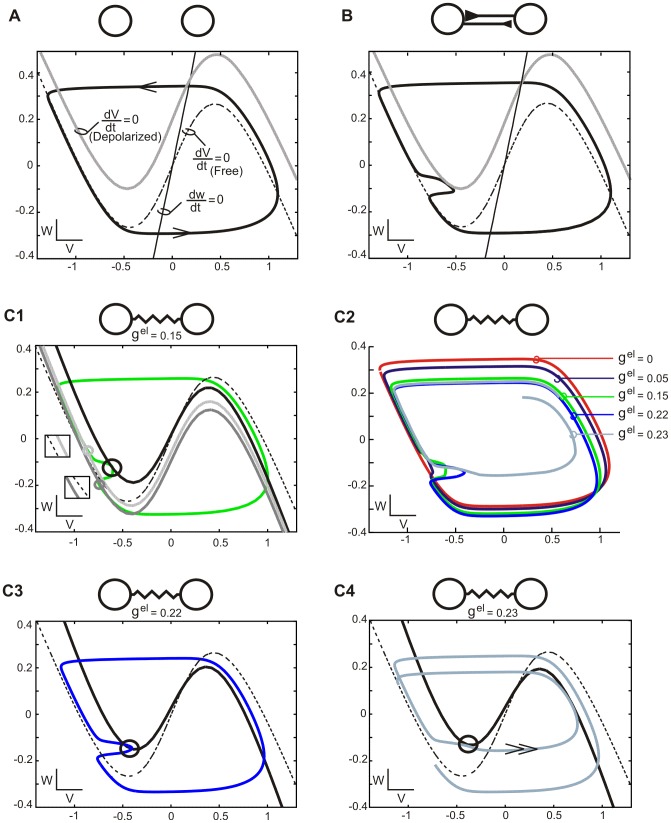
Phase plane evolution of oscillators involved in the 2-phase behavior in fully connected network.A. Trajectory of an uncoupled oscillatory cell (black curve) on the phase plane. Evolution along left and right branches of V-nullcline (dashed cubic curve) corresponds to the active and silent phases, respectively. Transitions between the phases occur when the cell jumps up from the left knee or jumps down from the right knee of the V-nullcline (see arrows). The speed of evolution is high during jumps as compared to evolution along V-nullcline when it is inversely proportional to the distance between the actual position of the cell and the W-nullcline (black straight line). Also shown is the V-nullcline for depolarized system (grey cubic curve). B. AP trajectory of 2 cells coupled reciprocally by excitatory synapses. The trajectory (black curve) is identical as in A, except for a right-sided deflection, corresponding to the evolution along the new V-nullcline (grey cubic curve) of the depolarized cell, which is shifted up with respect to the free nullcline (dashed cubic curve). C. AP trajectory of electrically coupled cells. The trajectory of two identical groups of cells expressing anti-phase oscillation (green curve, C1) is compressed comparing to the free cell trajectory (black curve, A) due to continues interaction of two groups all over the cycle. Shown are positions of cells before, during and after the other group's active phase (light grey, black and dark grey circle, respectively) and corresponding nullclines (light gray, black and dark grey cubic curves). Notice shift of the nullclines with respect to the free nullcline (dashed cubic curve) (inserts, C1). Increasing gel produces gradual compression of the AP trajectory (color curves, C2) and changes a position of cells (black circles) with respect to the knee of V-nullcline (black cubic curve) during a maximal deflection (C3-4, see also C1). When the knee of the nullcline is shifted above a cells' actual position (see black circle and solid cubic curve) a jump up occurs directly from the deflection phase to the active phase (see double arrow) and the AP solution disappears (light blue curve) (C4). Parameters: N = 2 (A-B), 24 (C), Ncc = 23 (C), in B parameters as described in Methods. Phase plane coordinates: V (abscissa), W (ordinate). Trajectories and nullclines were calculated using the software XPPAUT developed by B. Ermentrout (http://www.pitt.edu/~phase/).